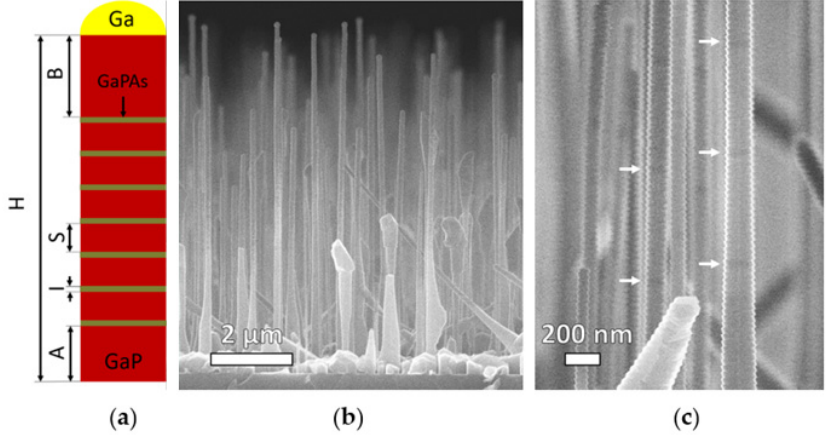
Figure 1. ( a ) Synthesized NW heterostructure schematics (not to scale) with estimated mean dimensions A (stem) = 2 µm, B (top GaP segment) = 2 µm, I (GaPAs insertion) = 50 nm, S (GaP segment) = 600 nm, H (NW length) = 7.8 µm. SEM images of the heterostructured GaPAs/GaP NW array morphology: cross-section view on a cleaved edge ( b ) and close-up NW view with GaPAs NDs marked by white arrows ( c ).